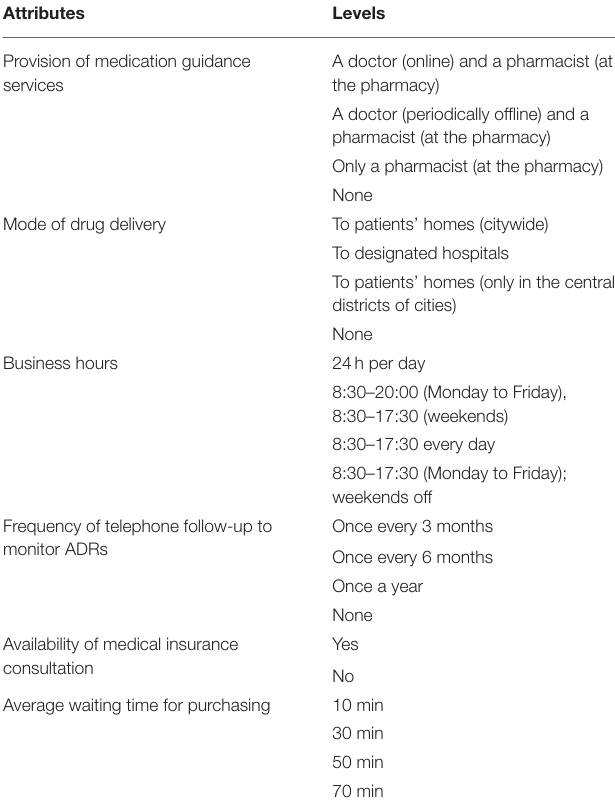
TABLE 1 | Attributes and levels.